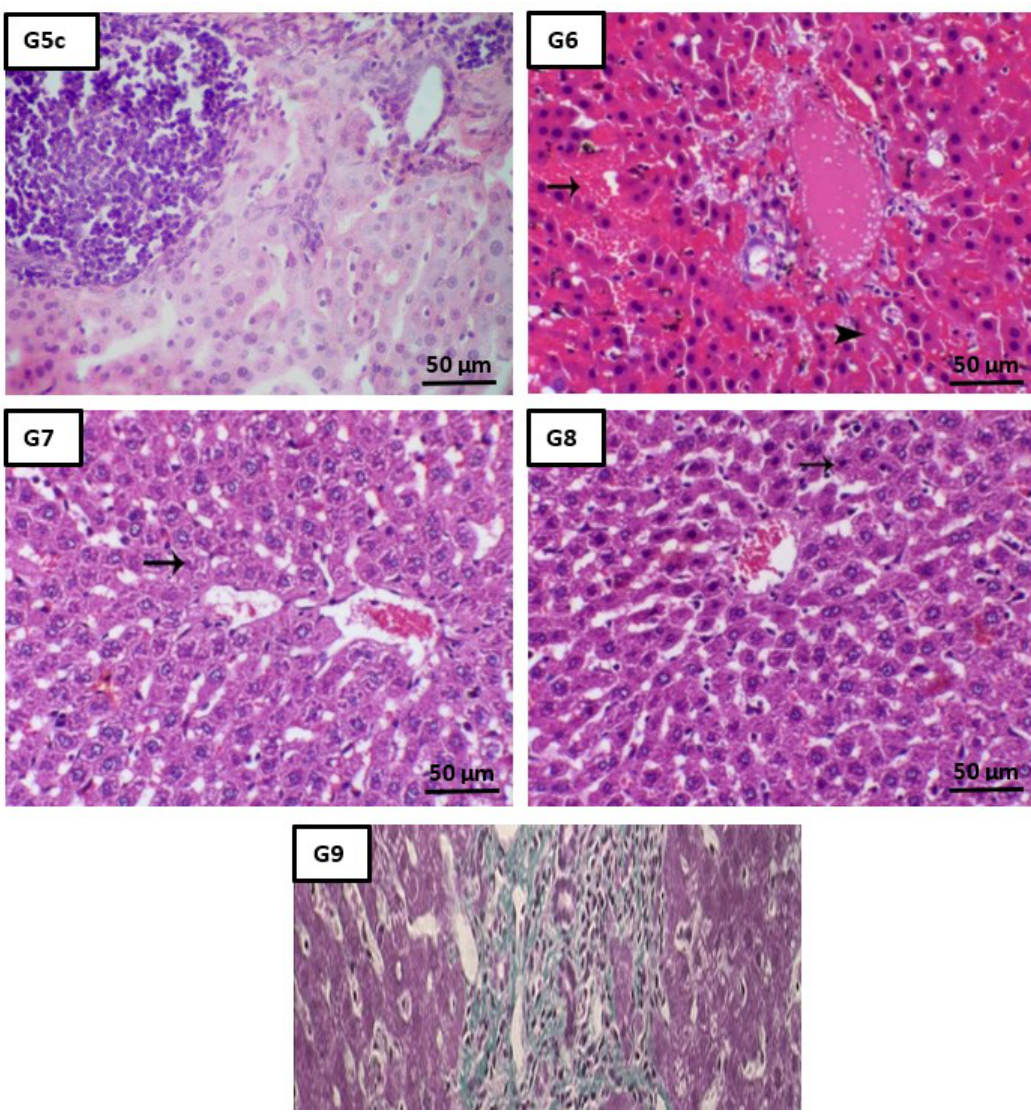
Figure 5. Effect of different studied compounds on the liver histology. Liver tissues from the control group (G1: H&E, ×200, Scale bar ⁼ 80 µm) showed a normal lobular architecture, individual hepatocytes disclosed no pathology, and the portal triad was undetected. Liver tissues of groups CSNPs, DBT, and DBT–CSNPs (G2–G4, respectively: H&E, ×200, Scale bar ⁼ 80 µm) exhibited normal hepatocytes around the central vein. A tissue sample from the intoxicated CCl 4 group (G5: H&E, ×200, Scale bar ⁼ 80 µm) revealed cellular infiltration, congestion of central vein, mild portal inflammation, hemorrhage as well as centrilobular hepatic necrosis, and focus of lytic necrosis & dispersed apoptotic bodies both intra & extracellular in location. The specimen of CSNP-treated rats (G6: H&E, ×200, Scale bar ⁼ 80 µm) demonstrated congestion of the central vein and hemorrhage (arrow) and centrilobular hepatic necrosis (arrowhead). The specimen of DBT-treated rats (G7: H&E, ×200, Scale bar ⁼ 80 µm) confirmed a mild degree of hepatic degeneration represented by cell swelling (arrow). On the contrary, the liver tissue of DBT–CSNP-treated rats (G8: H&E, ×200, Scale bar ⁼ 80 µm) revealed a marked decrease in hepatic degeneration unless single cell degeneration (arrow). Moreover, a periportal inflammatory reaction with a degenerated hepatic cord and disrupted cell plates was observed in the tissue of the cisplatin-treated group (G9: H&E, ×200, Scale bar ⁼ 80 µm). These histopathological results revealed the hepatoprotective effects of DBT and DBT– CSNPs, confirming the biochemical analysis.